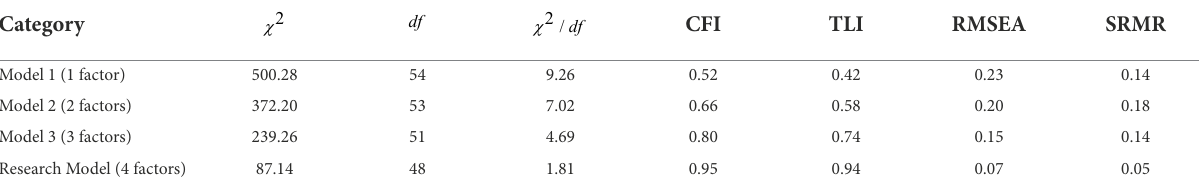
TABLE 2 The confirmatory factor analysis